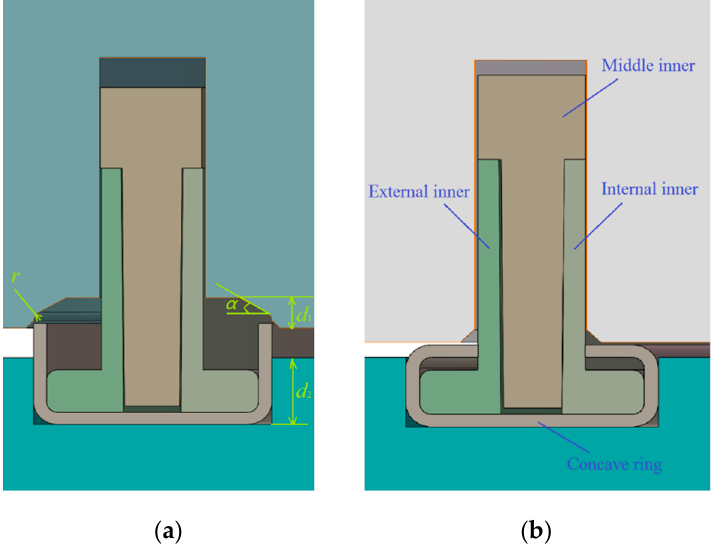
Figure 5. Installation drawing of stamping die. ( a ) First pass; ( b ) second pass.